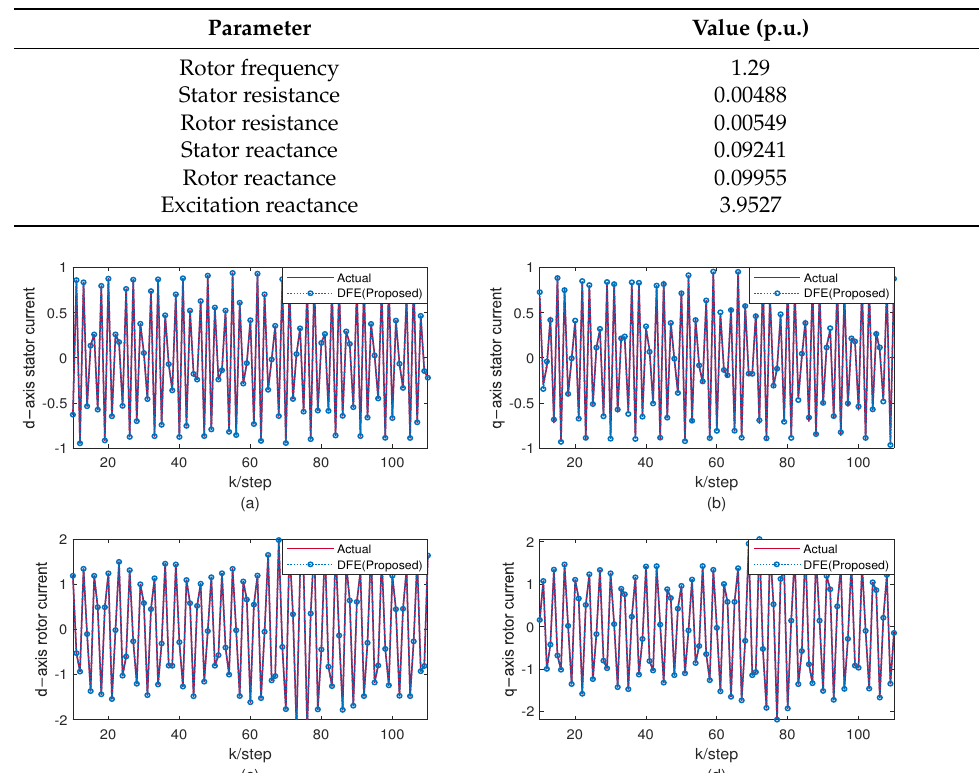
Table 1. The parameters of wind generator.